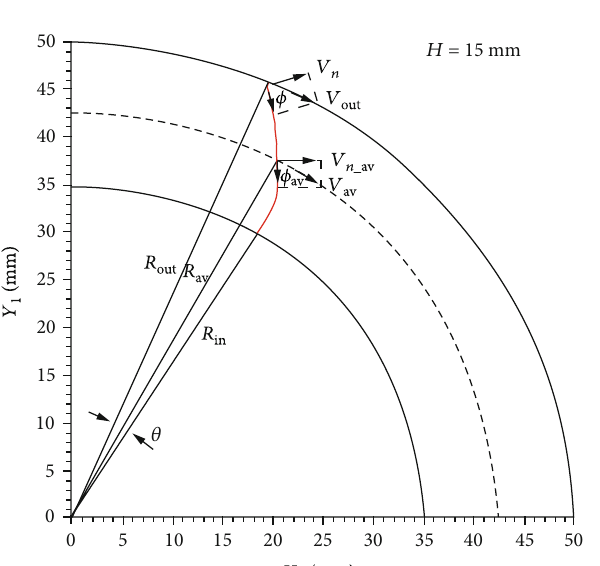
Figure 8: Variation of the detonation wave ( H = 15 mm).